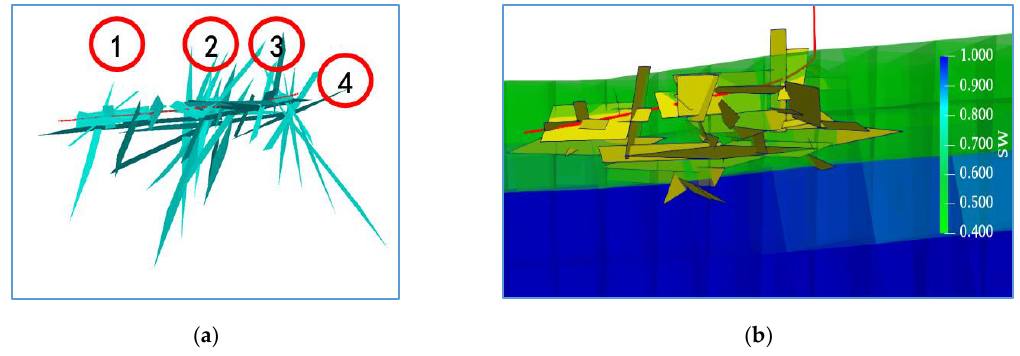
Figure 22. Four shortest fracture paths from well B3 to the water contact: ( a ) 3D visualization of the fractures paths along the wellbore; ( b ) shortest fractures planes embedding the grid blocks displaying a vertical intersection plane view of the water saturation of the matrix.